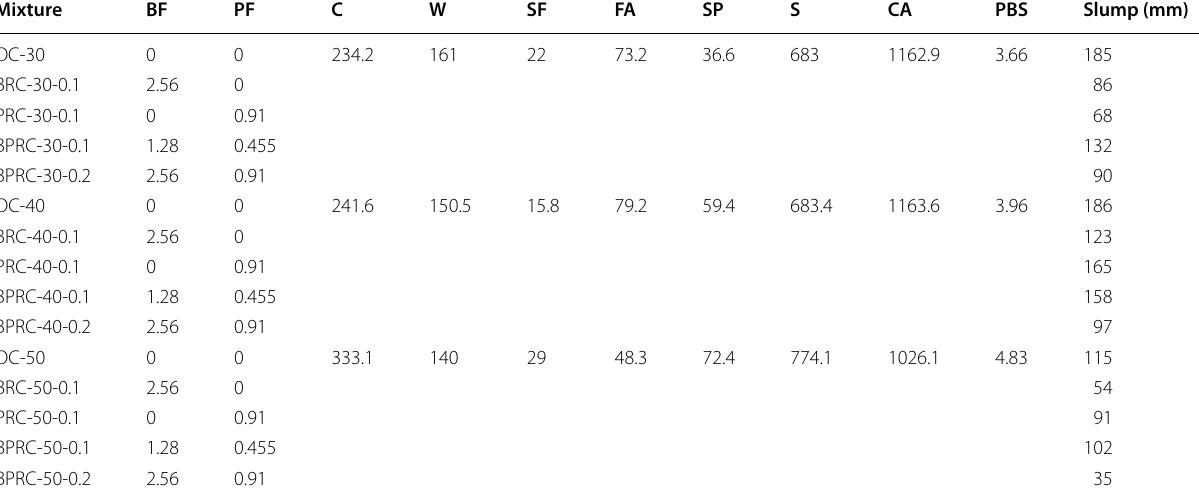
Table 1 BPRC mixture proportions (kg/m 3 ).